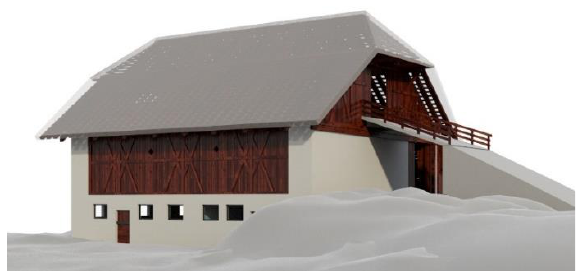
Figure 2: Perspective view of the farmhouse’s 3D model.